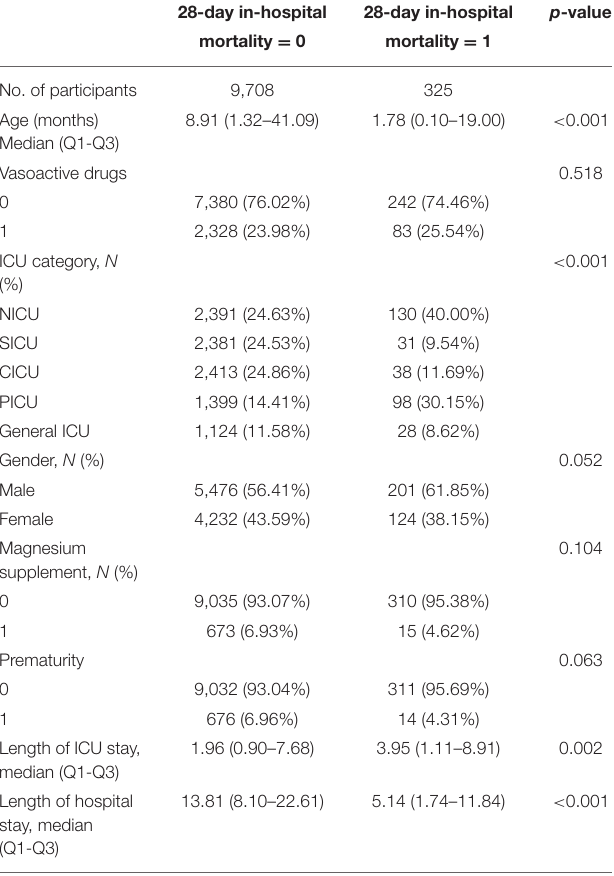
TABLE 1 | Baseline characteristics of the study participants.